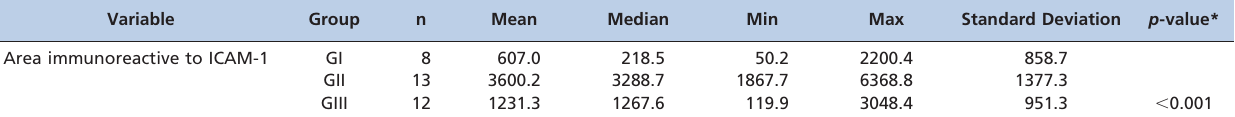
Table 2 - Area showing immunoreactivity to ICAM-1 antibody, in square micrometers, obtained from the color morphometry analysis.